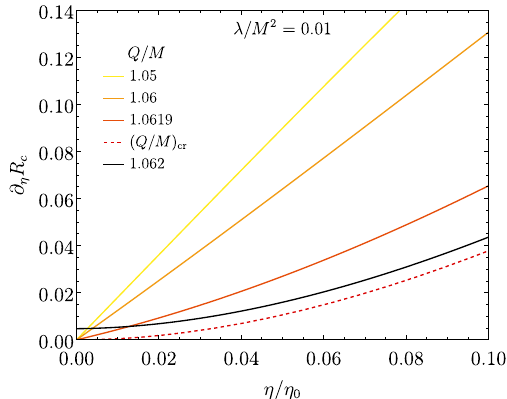
Fig. 18 Formation of a degenerate throat λ/ M 2 = 0 . 01. Shown is the derivative ∂ η R c as function of η/η 0 for several values of Q / M , approaching the critical value Q / M ≈ 1 . 062